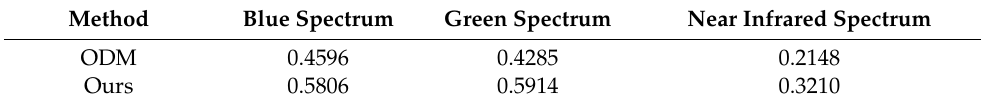
Table 6. SSIM values of ODM and our methods on BGNIR multispectral aerial image mosaic.